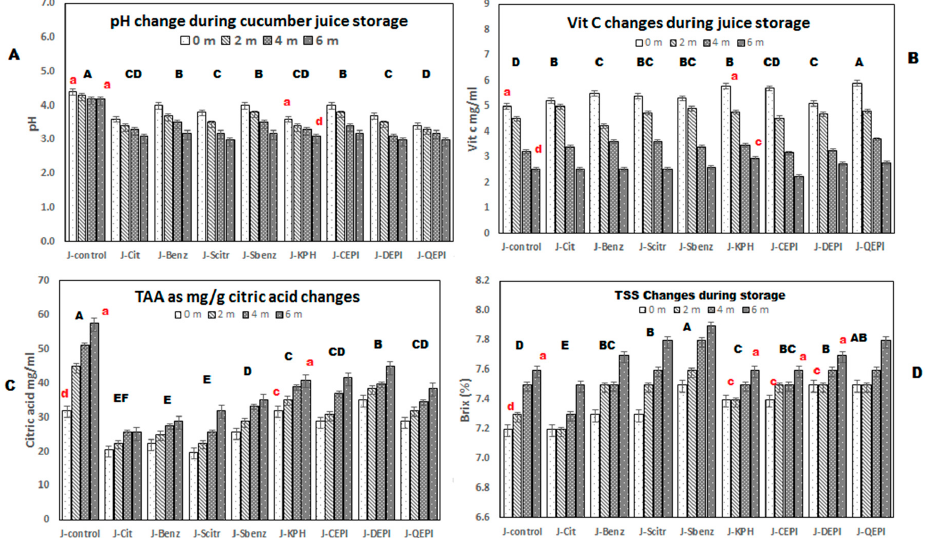
Figure 3. Chemical parameters’ changes during cucumber juices storage for zero to six months, at room temperature. Mean with di ff erent red lowercase letters that above columns are significantly di ff erent during storage, with di ff erent capital letters, significantly di ff erent between samples ( p ≤ 0.05). ( A ) pH change during cucumber juice storage; ( B ) Vit C change during juice storage; ( C ) TAA as mg / g citric acid changes; ( D ) TSS changes during